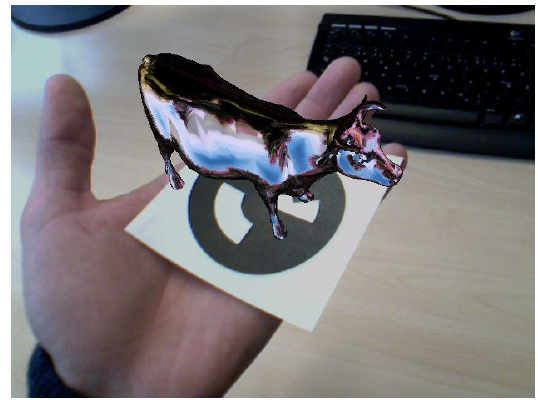
Figure 3: Example of a circular marker with